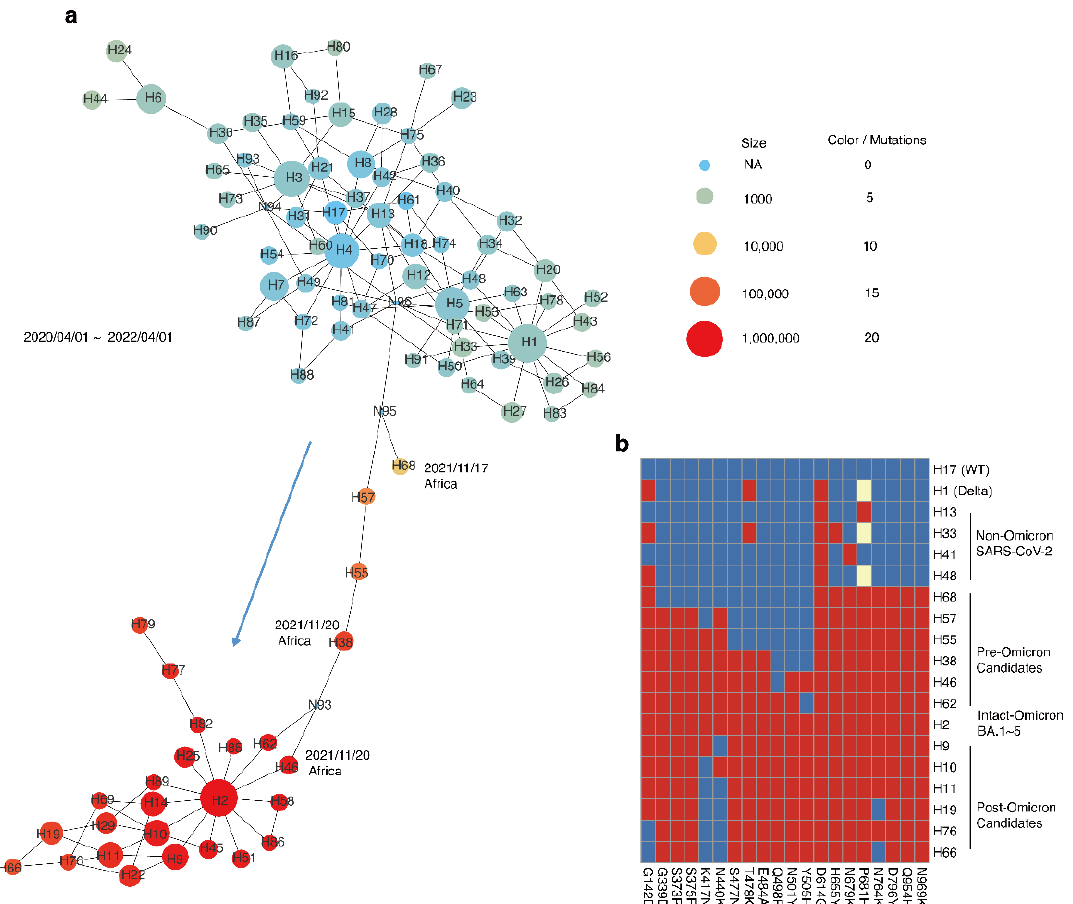
Figure 2. Haplotype networks of SARS-CoV-2 and the flow of Omicron core mutations. ( a ) Haplotype network of 20 core sites with genomes collected from 2020/04/01 to 2022/04/01. Node sizes represent the number of haplotype members; the color represents the number of omicron core mutations (blue–yellow–red: 0–10–20 core mutations); edges indicate the mutation steps. Haplotypes are named by their size rank from large to small: H1 to H93. N93 to N96 are undetected haplotypes. The arrow indicates the inferred order of haplotypes. ( b ) The profiles of 20 core mutations in the spike protein of Omicron. Red boxes are the core mutation types of Omicron; yellow boxes are the other amino acid mutation types; blue boxes are the wild types.